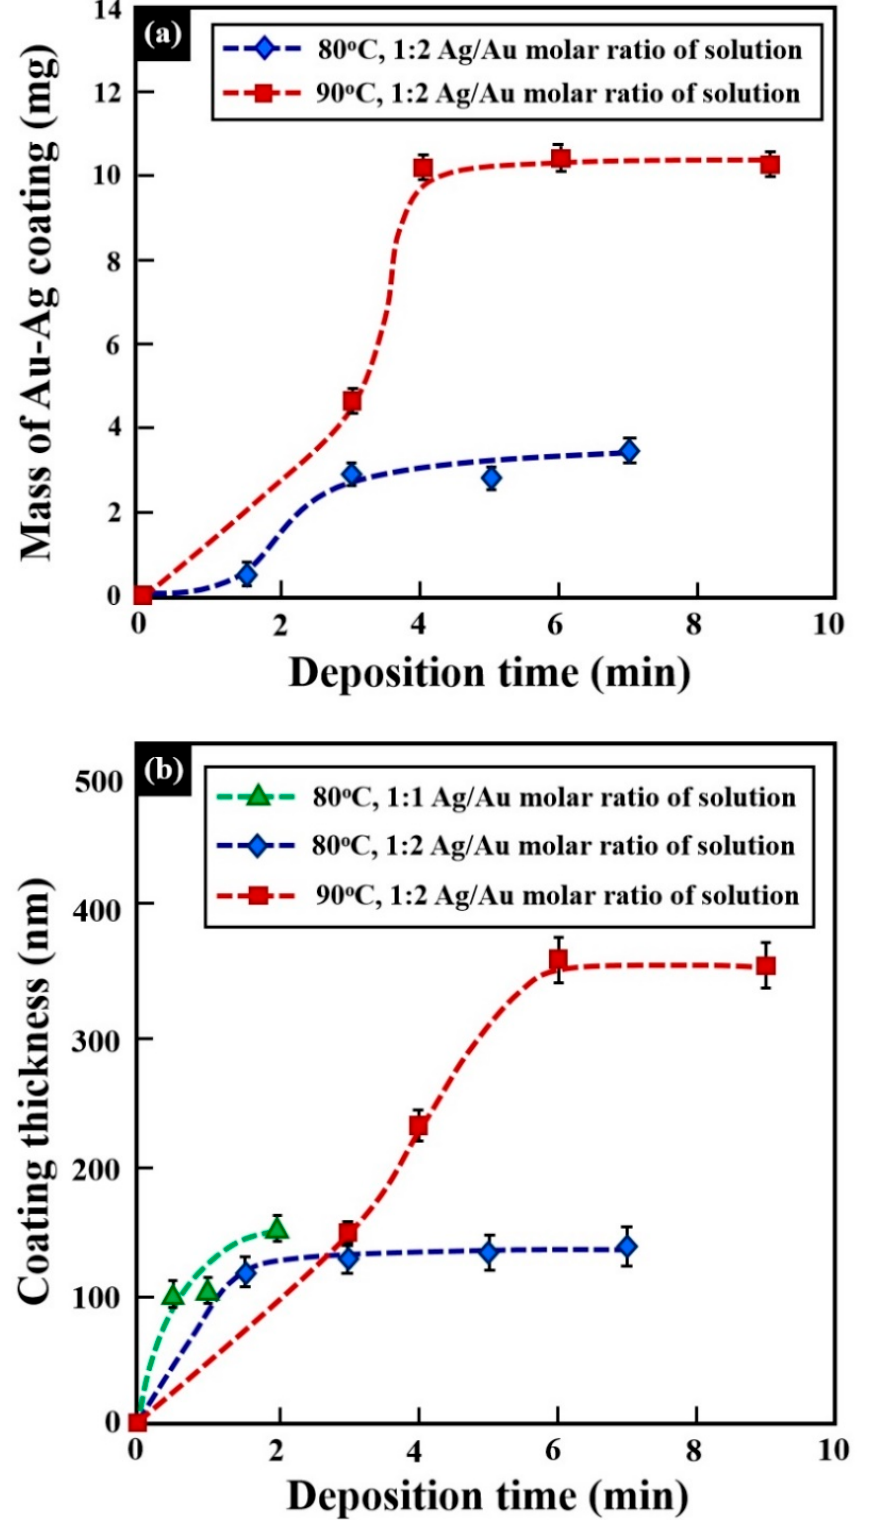
Figure 15. Laboratory-developed electrum (Au–Ag) coatings deposited at 80 and 90 °C: ( a ) mass of the coating after eliminating the Ni–P interlayer contribution vs. deposition time; and ( b ) thickness of the coating film (measured by X-ray fluorescence instrument) vs. deposition time.